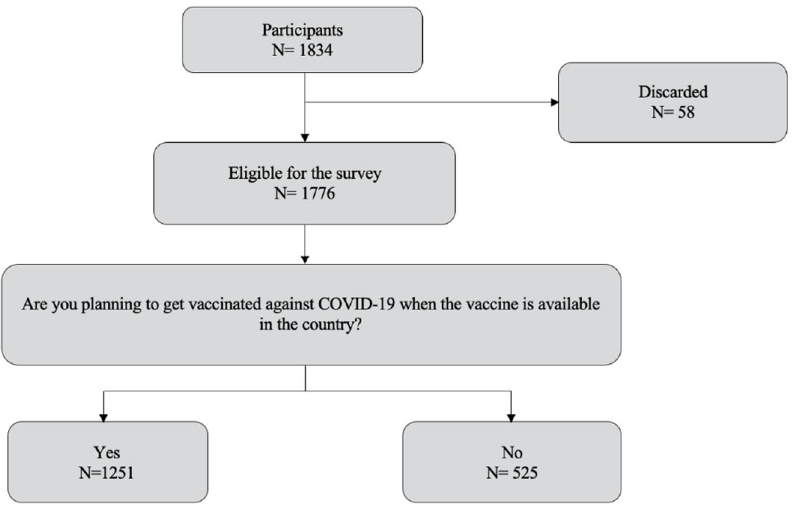
Figure 1. Flowchart of the survey respondents.